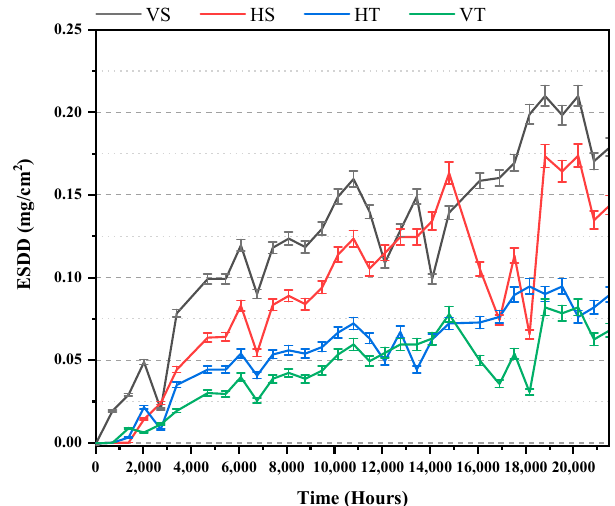
Figure 3. ESDD & NSDD measurements.